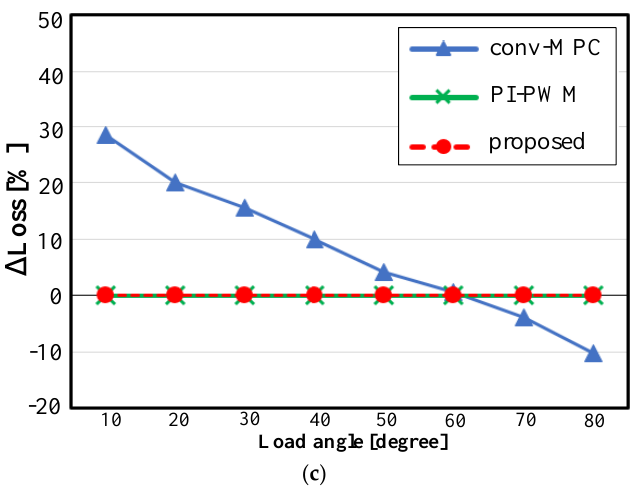
Figure 11. Loss performances of the three methods as a function of load angles. ( a ) Conduction and